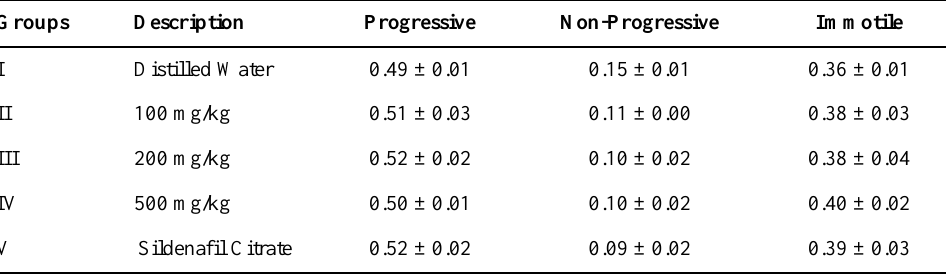
Table 1.2: Effect of MPAE on Sperm Motility of the male rats